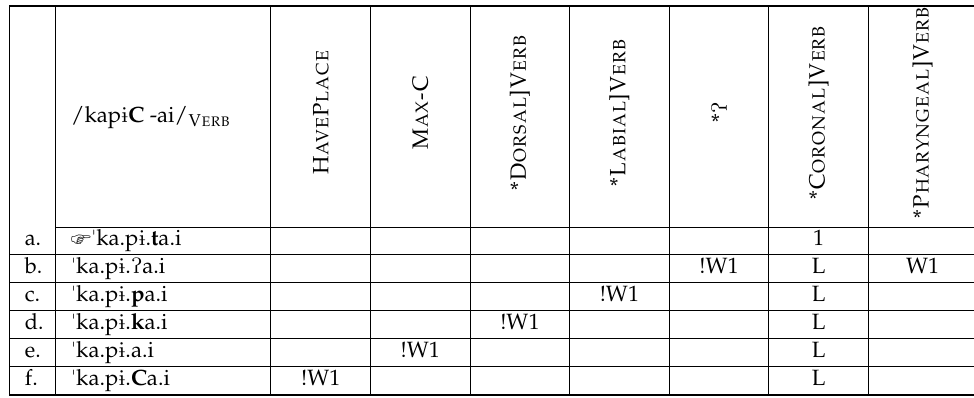
When a noun root like /kap 1 C / ‘alligator’ is turned into a verb as in /kap 1 C -ai/ ‘(s/he) becomes an alligator’, the latent consonant of the root surfaces coronal, [ " ka.p 1 . t a.i], since its evaluation is, in this case, governed by the ranking in (77) for verb forms and not by that in (78) that is for non-verb forms. This is illustrated in Table 5. The constraints of Table 4. /kap ɨ C -aN/ → [ ˈ ka.p ɨ . p ãN] ‘alligator’ the ranking in (78) are not shown since they do not receive any violation. Table 5. /kap 1 C -ai/ → [ " ka.p 1 . t a.i] ‘(s/he) becomes an alligator’ (Shipibo-Konibo).